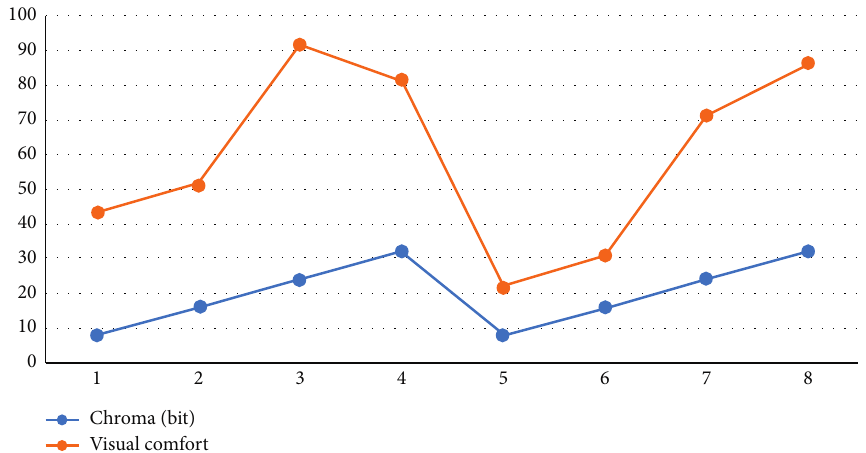
Figure 3: The relationship between visual comfort and chromaticity of the interior light environment for meeting guests.